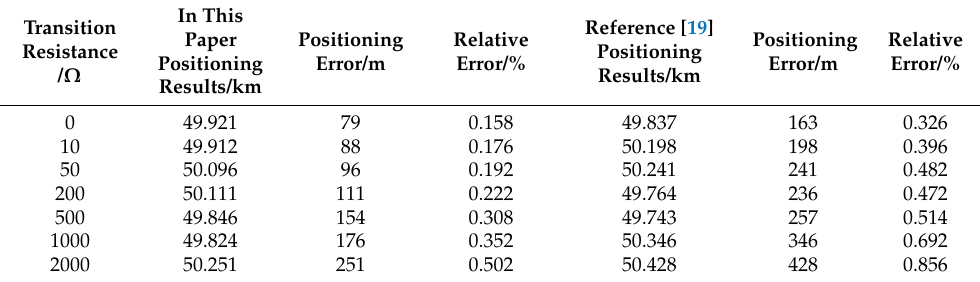
Table 1. Positioning results under different transition